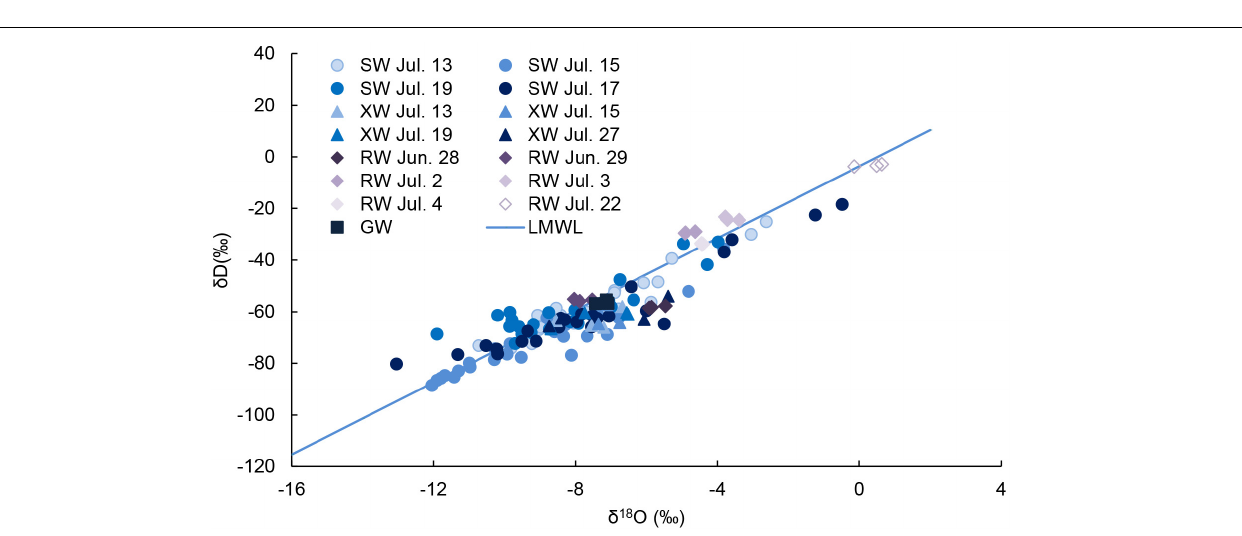
FIGURE 2 | The δ D and δ 18 O of xylem water (XW) of Caragana intermedia , soil water (SW), rainwater (RW), and groundwater (GW) in July 2016. LMWL is the local meteoric water line ( δ D = 6.977 × δ 18 O–3.668, R 2 = 0.849, P <